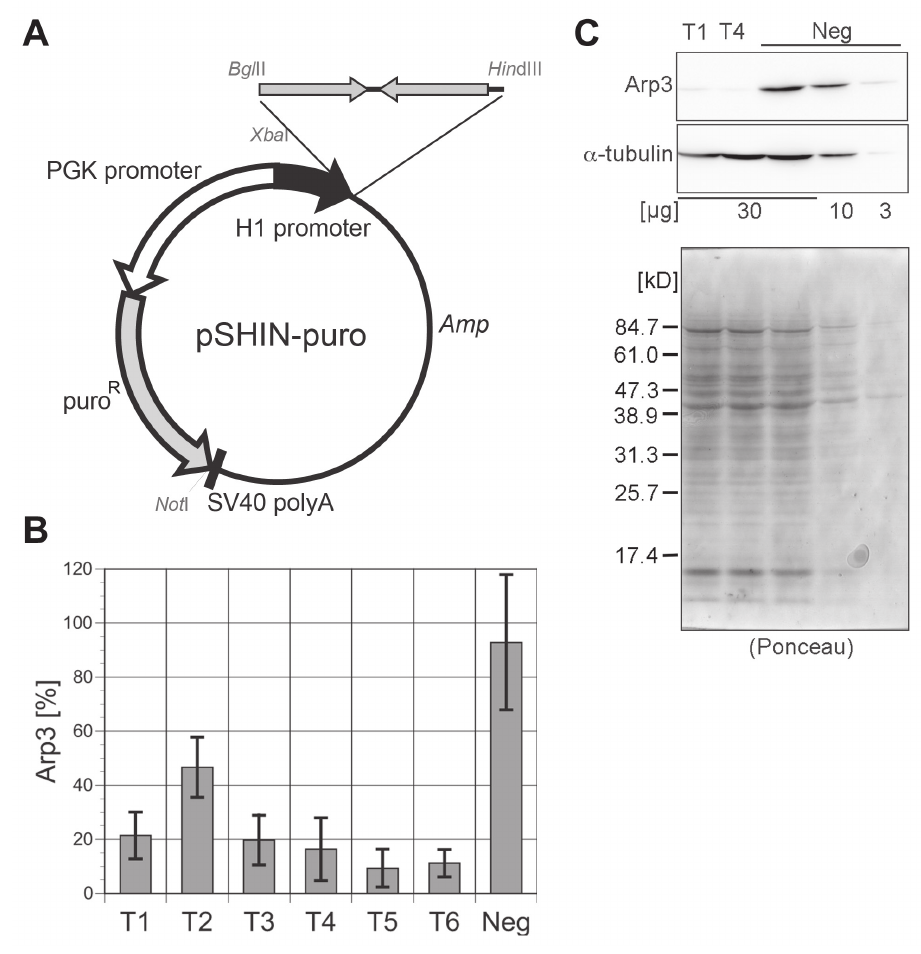
Supplemental Figure 6. RNAi of Arp3 in B16S and SCC9 cells. ( A ) The map of pSHIN-puro plasmids. Puromycin resistance gene is expressed under the PGK promoter, whereas shRNA is expressed under human H1 RNA promoter. ( B ) Quantification of expression level of Arp3 in B16S cells. Two independent experiments of Western blotting were analyzed. The remaining protein levels are expressed as percentages of the untransfected B16S cells. The averages and standard deviations are shown for RNAi by Arp3-T1 to -T6 and a negative control (Neg). ( C ) RNAi of human Arp3 with Arp3-T1 and -T4 in comparison to scrambled sequence (negative control, neg). SCC9 cells were transfected with pEpiso-shR[Arp3-T1], [Arp3-T4] or [neg]. Transfectants were selected in the presence of puromycin. The protein extracts were prepared and 30 µg of the T1 and T4 samples were loaded as well as a dilution series (30 µg, 10 µg and 3 µg) of the negative control (Neg) sample. The membrane was analyzed by blotting of rabbit anti-Arp3 antibody and mouse anti- α -tubulin antibodies. Ponceau-S staining of the membrane is shown below the Western blotting. Two independent experiments indicated that Arp3 protein level reduced to 7.8 +/- 5.1% and 5.1 +/- 4.6% by Arp3-T1 and -T4,